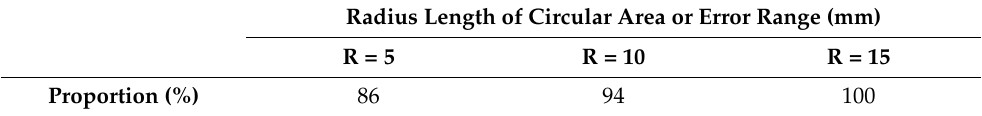
Table 2. Proportion of robot’s position in different areas.